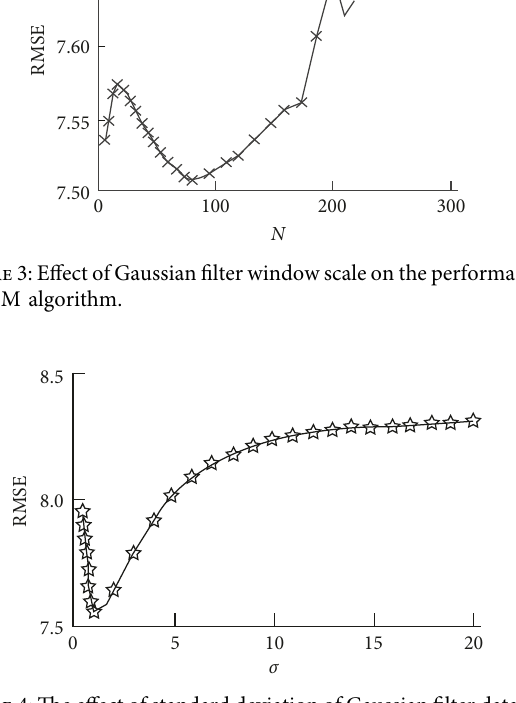
Figure 4: The effect of standard deviation of Gaussian filter data on the performance of SSIM